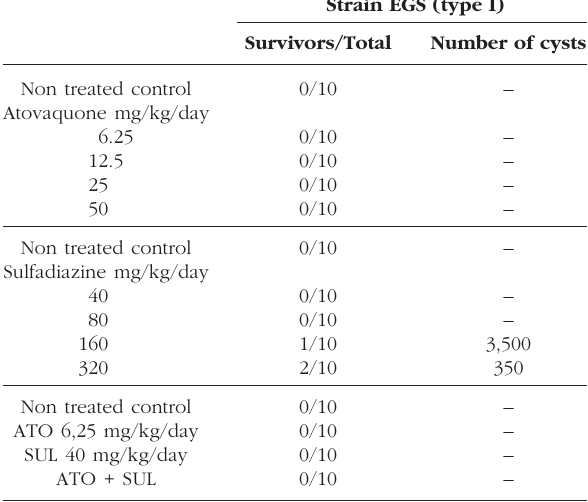
Table II. – Survival and number of brain cysts in mice infected with EGS strain of T. gondii and treated with different doses of atova- quone (ATO), sulfadiazine (SUL) or drug association (ATO + SUL).